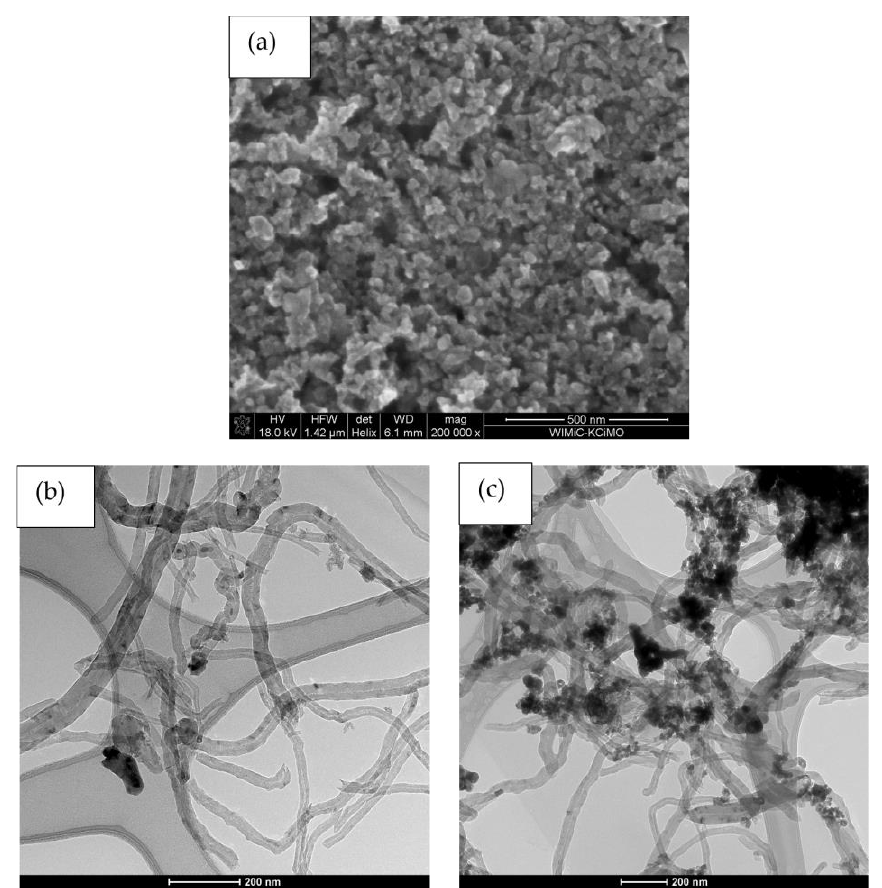
Figure 1. Microstructure of solid-contact materials:( a ) — SEM scan of IrO 2 , ( b ) — TEM scan of IrO 2 -NT, ( c ) — TEM scan of IrO 2 -NT-POT.